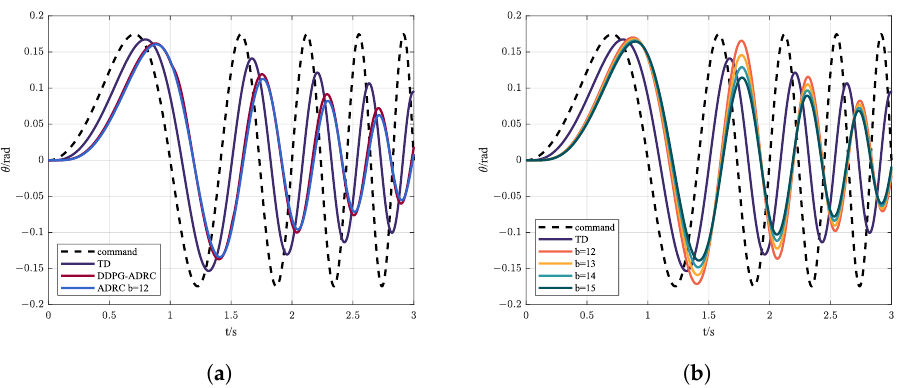
Figure 12. ( a ) Control instruction and state response via ADRC and DDPG-ADRC under sine sweep; ( b ) control instruction and state response via MPC with different b under sine sweep. Table 4. Evaluation indicators of MPC, ADRC, and